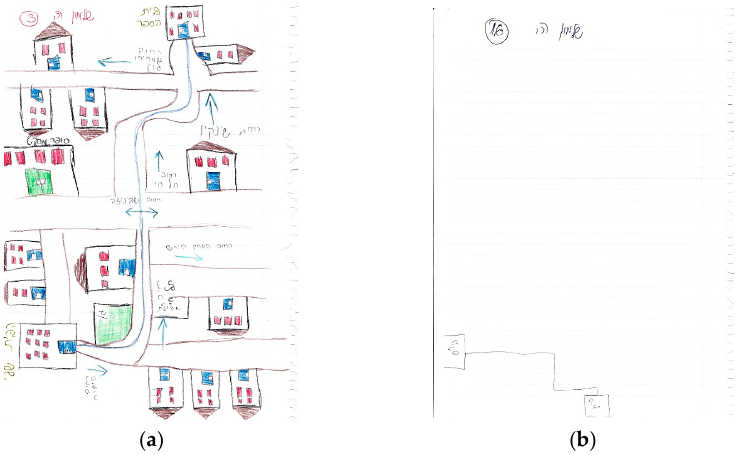
Figure 4. ( a ) a drawn sketch map with a high richness score (10/16), ( b ) a drawn sketch map with a low richness score (0/10).